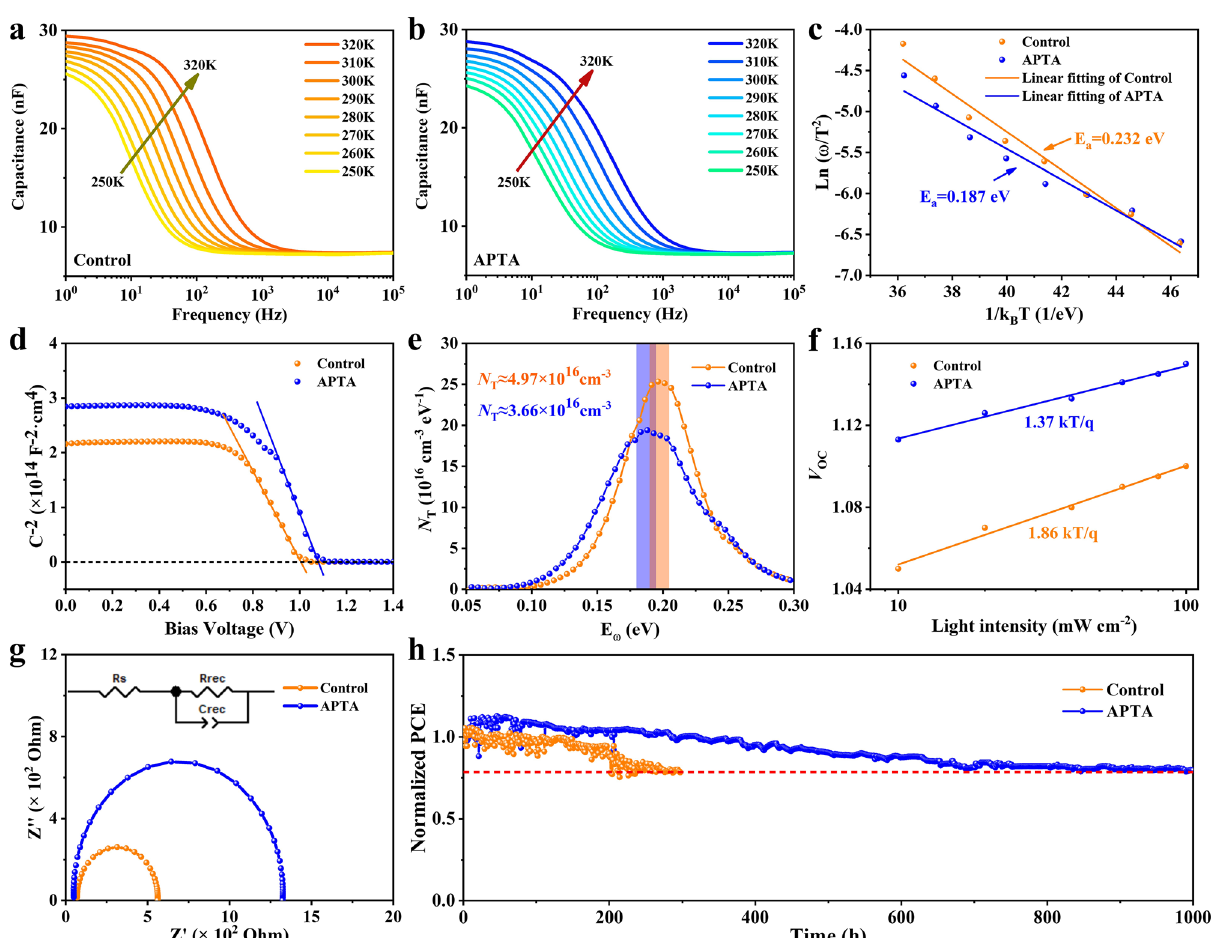
Fig. 5 Admittance spectra of WBG PSCs a without and b with APTA incorporation. c The Arrhenius plots, d the Mott–Schottky plots, and e the trap state density at room temperature. f V OC as a function of light intensities. g Nyquist plots of PSCs without and with APTA incorporation. h Continuous maximum power point (MPP) tracking for 1,000 h of PSCs without and with APTA under constant simulated solar illumination (100 mW cm −2 ) in nitrogen